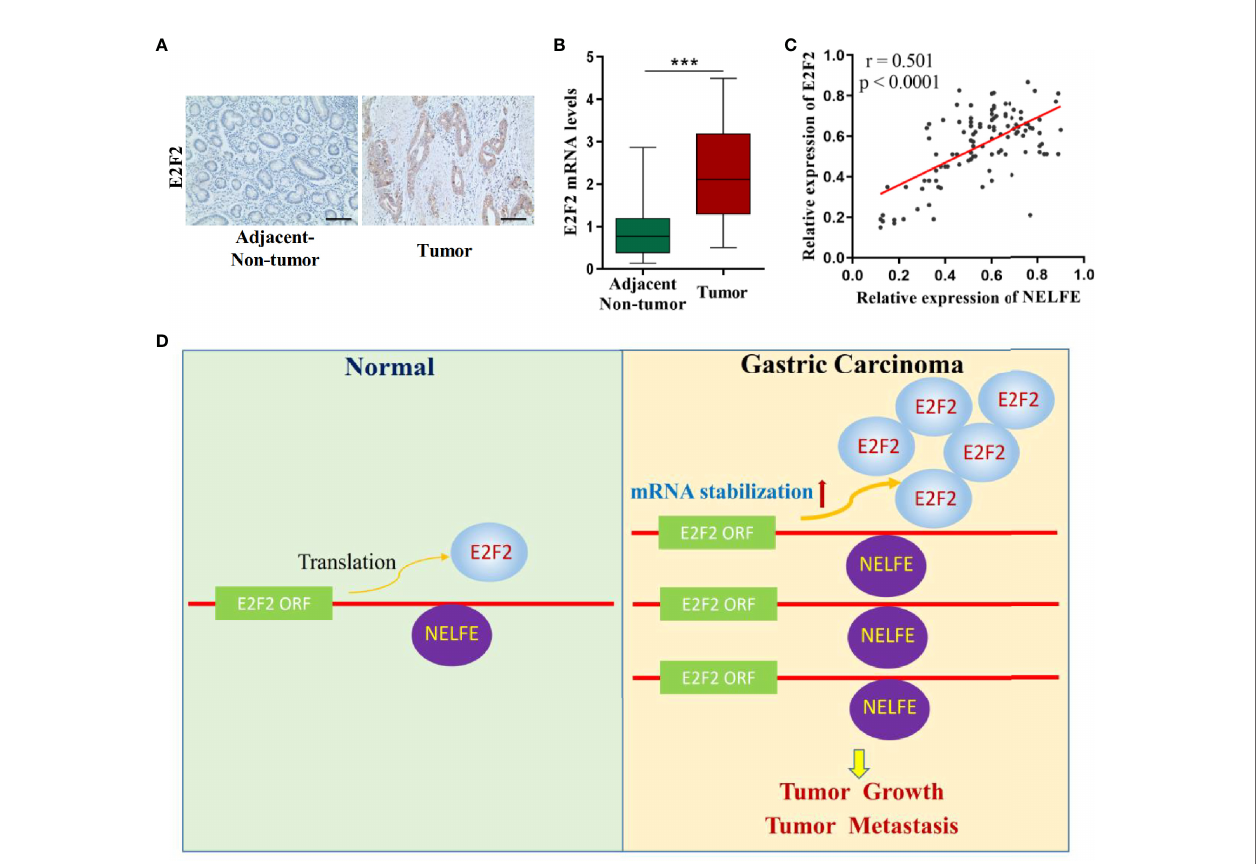
FIGURE 7 | E2F2 expression was elevated in gastric cancer and is positively correlated with NELFE. (A) Expression levels of E2F2 in gastric cancer tissues and normal gastric tissues were examined by immunohistochemical examination. (B) The expression levels of E2F2 in 32 pairs of fresh tumor tissues and adjacent nontumor tissues were detected by qRT-PCR. (C) The correlation between NELFE and E2F2. (D) The molecular mechanism of upregulation of E2F2 mRNA through NELFE in promoting gastric cancer pathogenesis. ***P <